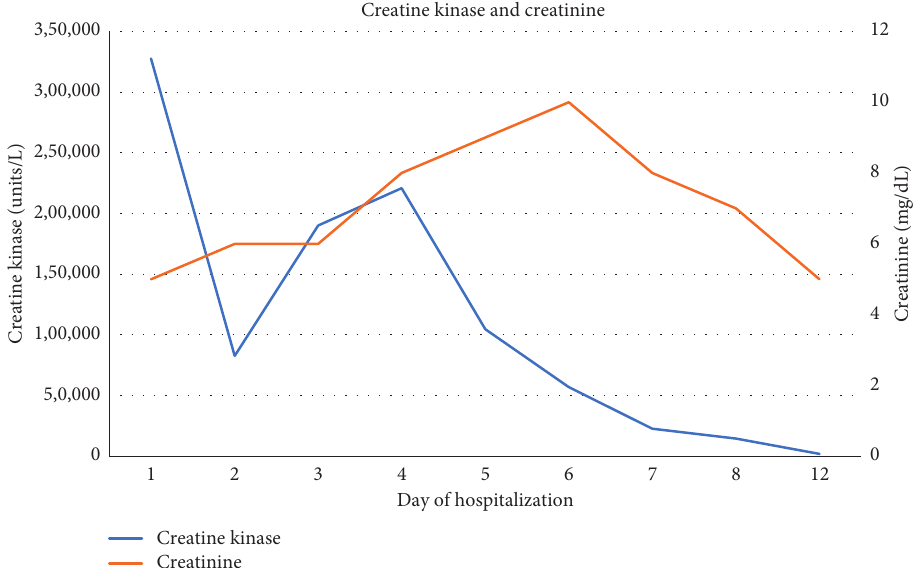
Figure 1: Trend of creatinine kinase and creatinine.